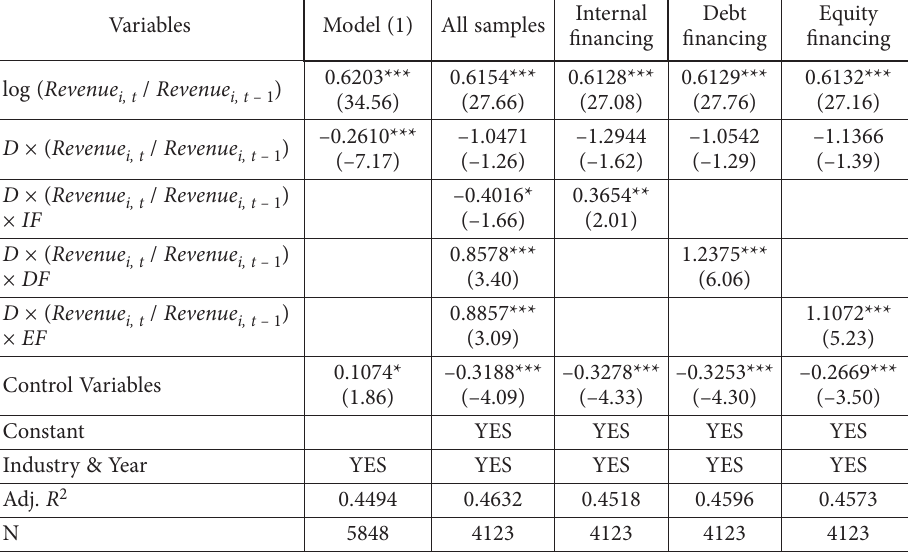
Table 6. Regression results of financing constraints on S&M expense stickiness